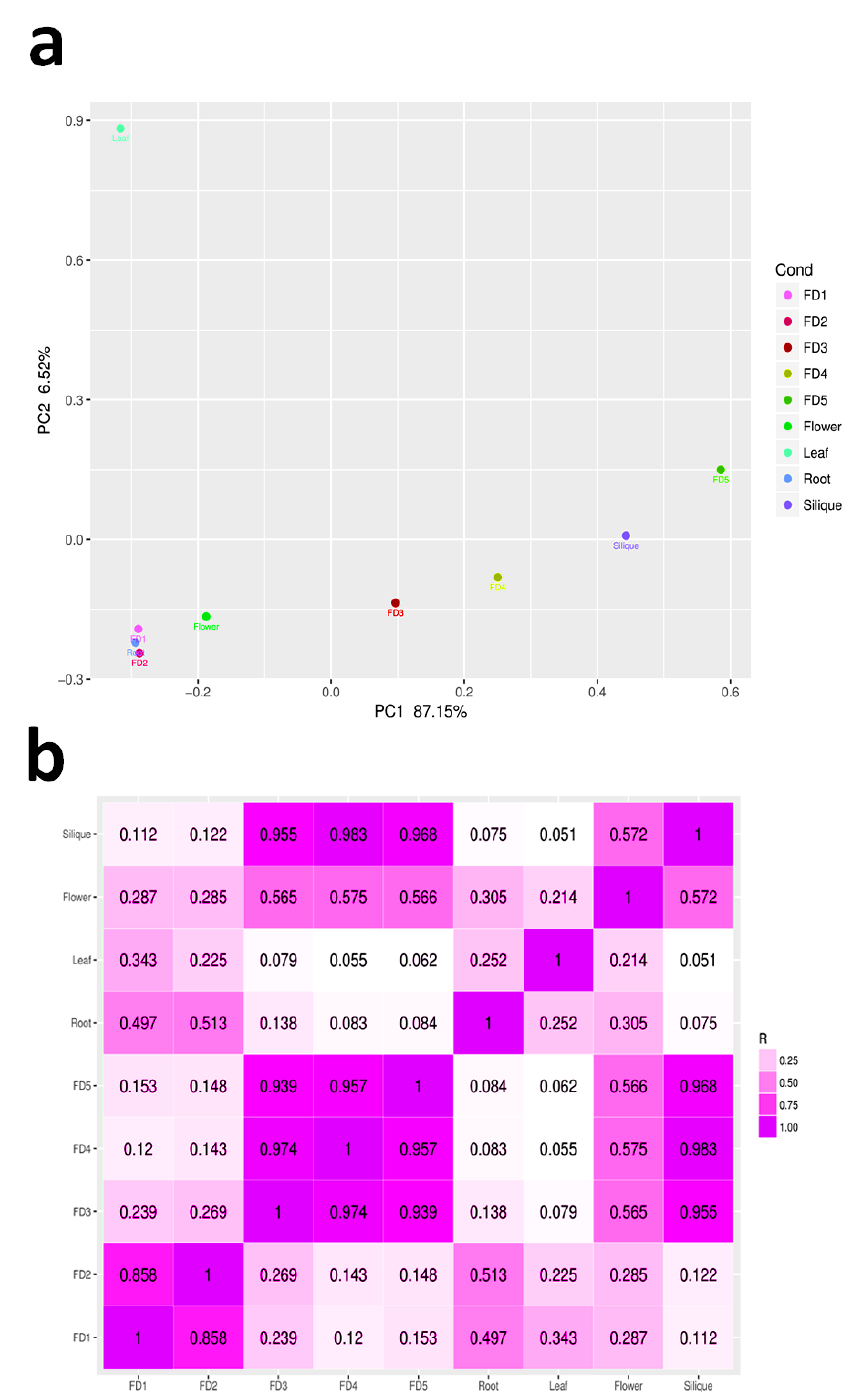
Figure 1. Principal component analysis ( a ) and Pearson correlation coefficient analysis ( b